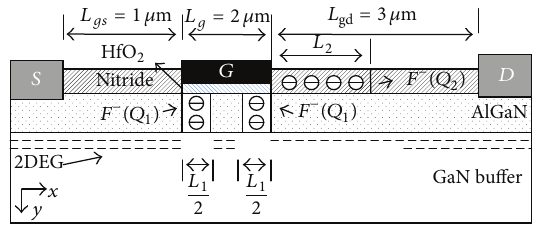
Figure 1: Schematic cross section of the proposed SFCP-MIS-HEMT.